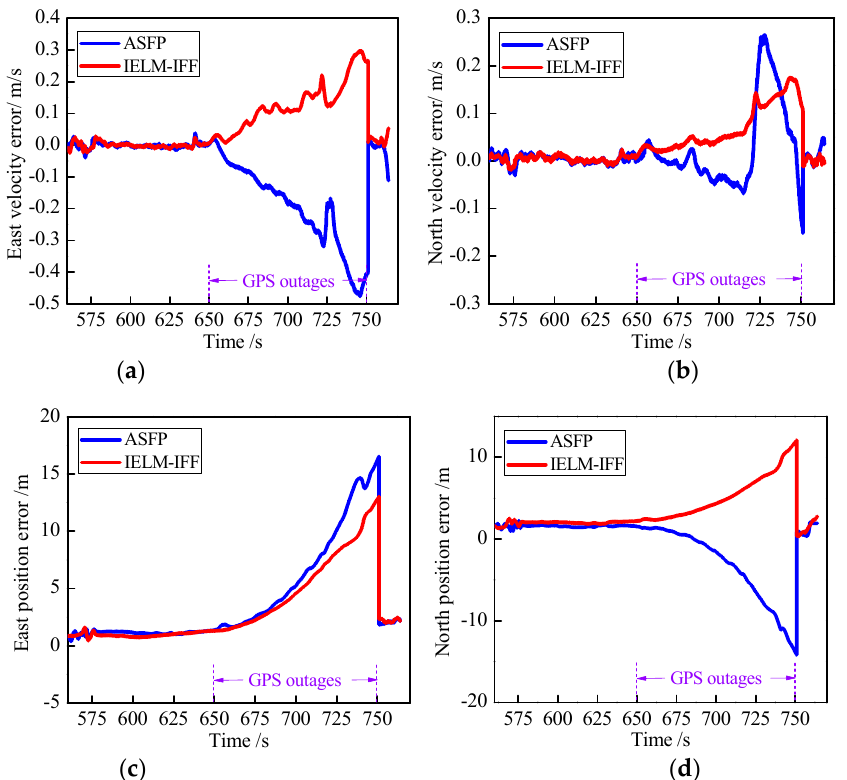
Figure 15. Curves of the east velocity error ( a ), north velocity error ( b ), east position error ( c ), and